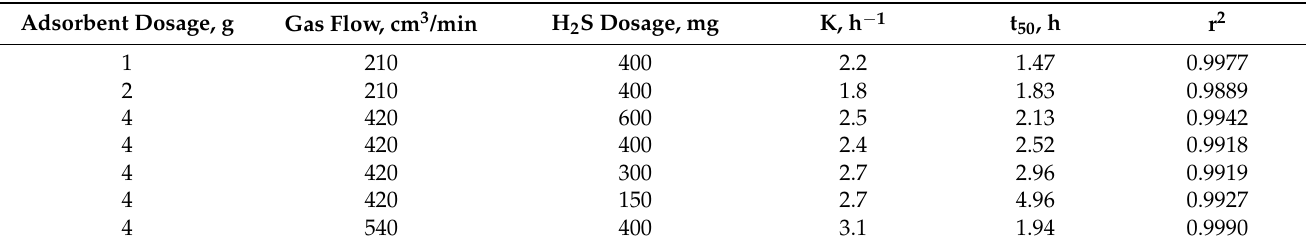
Table 4. Parameters of Equation